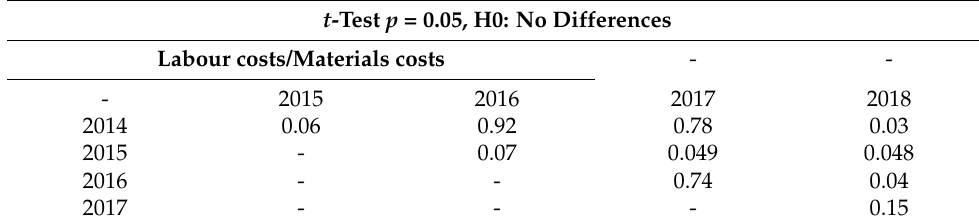
Table 6. Results of tests for differences.